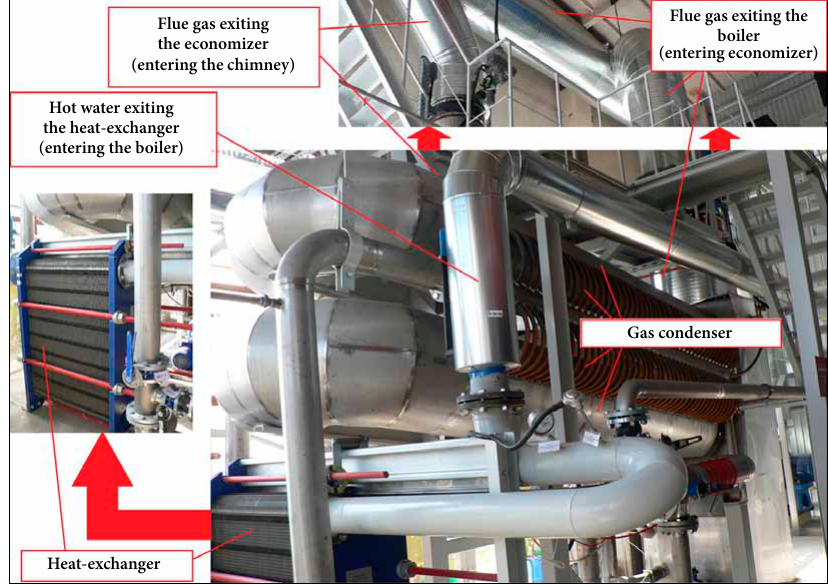
Fig. 4. Condensing economizer unit at biofuel